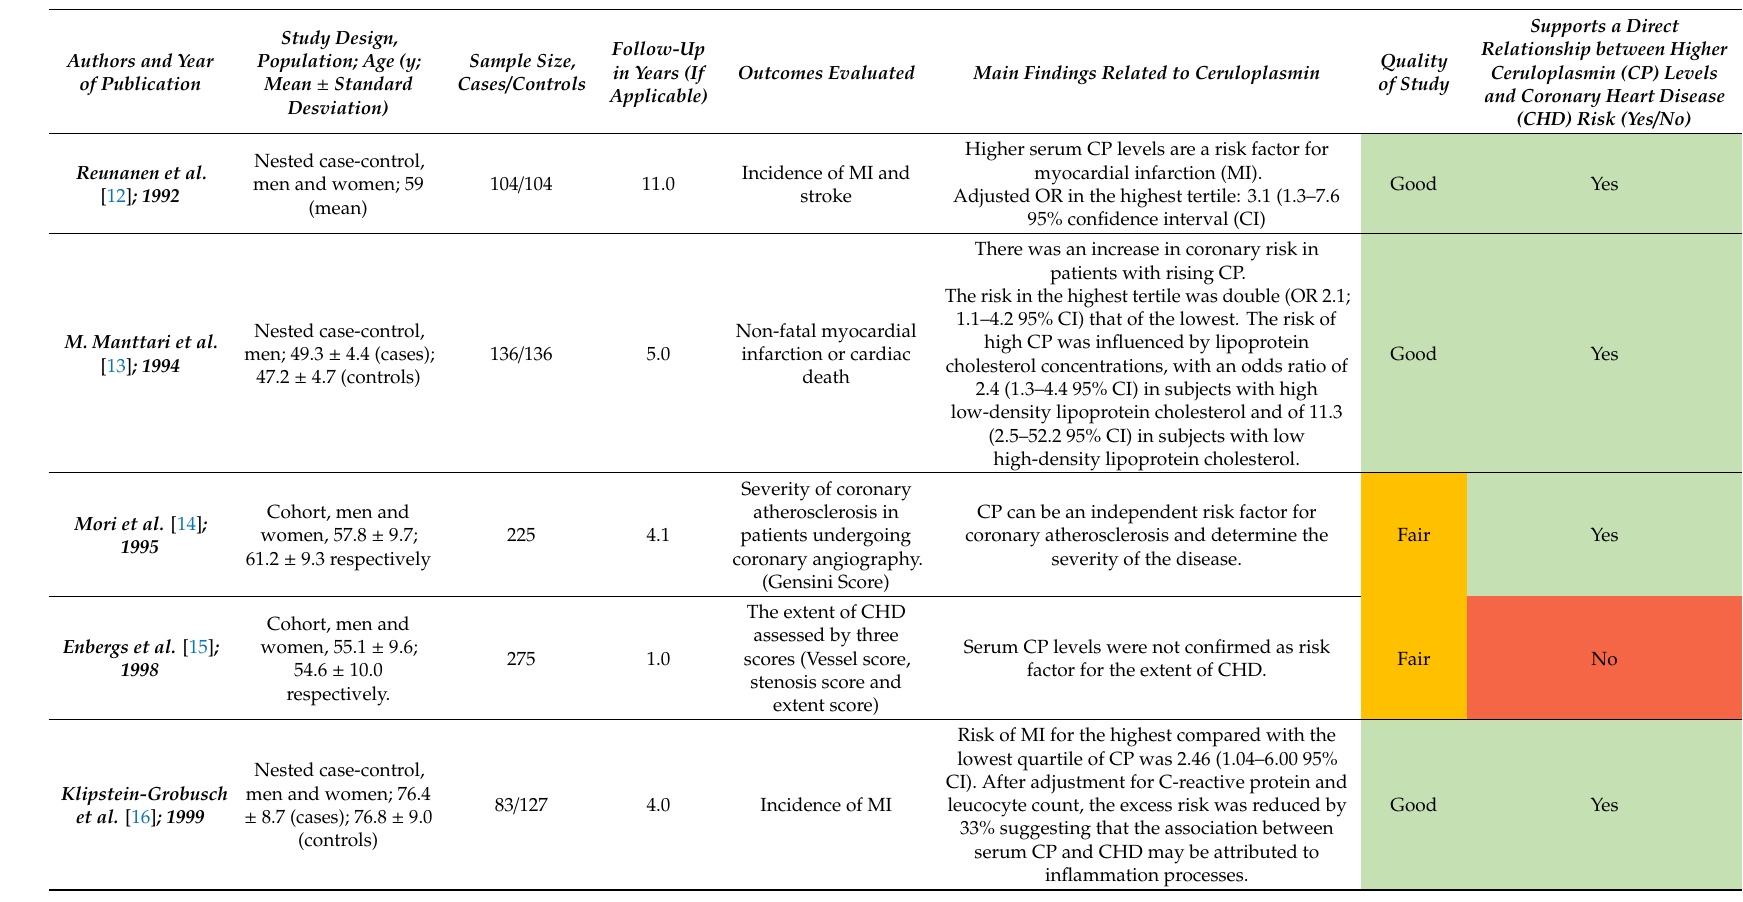
Table 2. Summary of the articles included in this